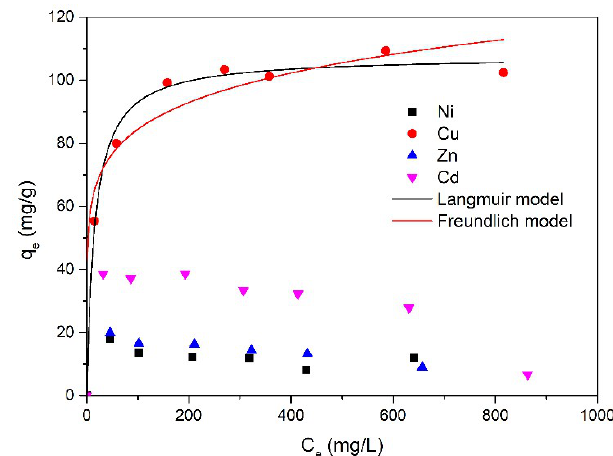
Figure 5. The selective removal and adsorption isotherm by CA beads in the mixed heavy metals solution at different initial concentrations. Reaction conditions: T = 293 K, [Cu(II)] 0 = [Zn(II)] 0 = [Ni(II)] 0 = [Cd(II)] 0 = 0–800 mg/L, reaction time = 12 h. q = the equilibrium adsorption capacity of heavy metal